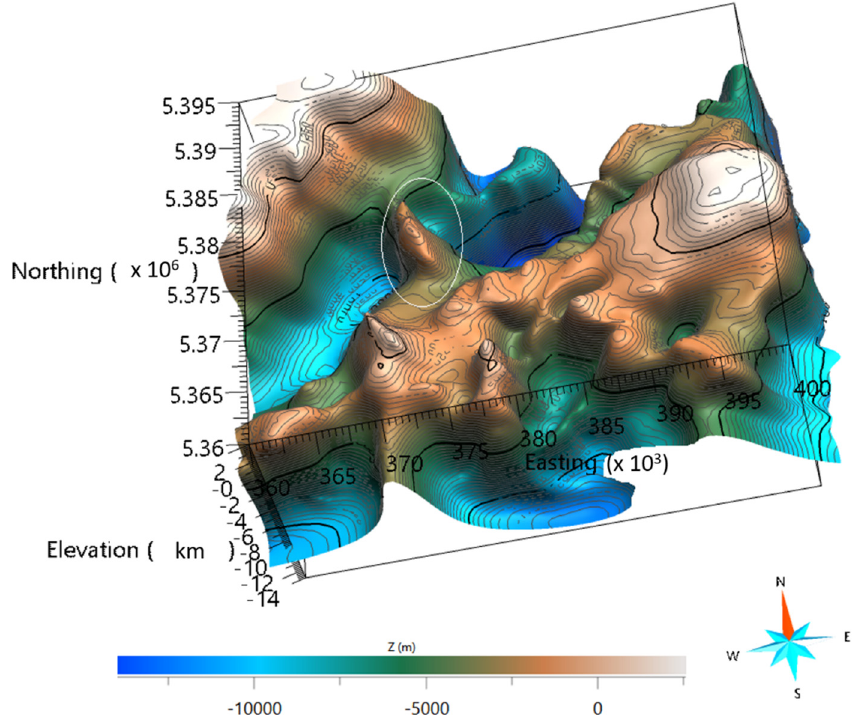
Figure 10. The geometry of the low-density Devonian granite was varied via inversion to account for a 10 mGal negative residual. This took the form of a spine underlying this region (white ellipse). Depth to this crest at its shallowest is estimated to be ~1000 m.